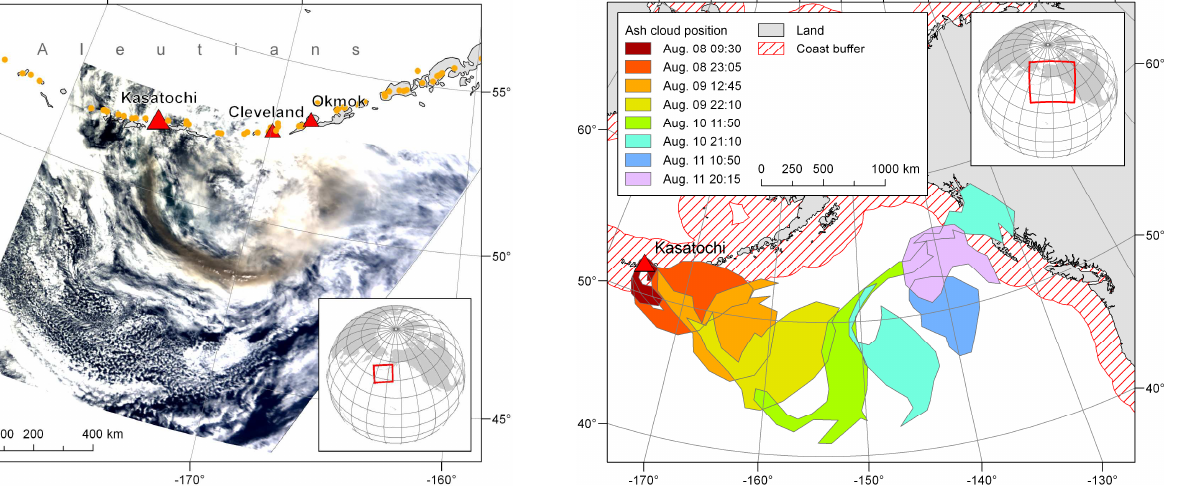
Fig. 1. Aleutian and Alaska volcanoes (orange circles) with Kasatochi, Cleveland and Okmok indicated as red triangles. The ash cloud released from Kasatochi volcano on 8 August is visible in brownish colours in the MODIS satellite image showing the visible wavelength range.